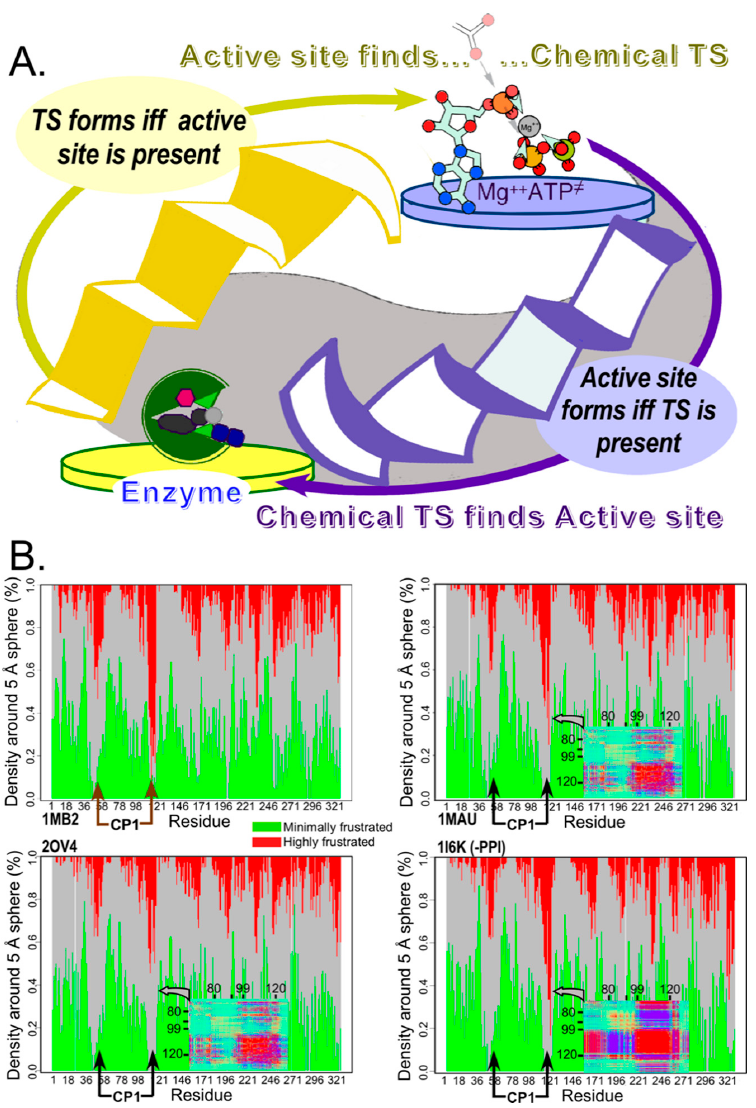
Figure 4. Reciprocally-coupled gating drove the evolution of catalysis. ( A ). The paradox of catalysis by molten globular ensembles is that both catalyst and reaction transition state are very rare species whose concentrations are too small to find one another often enough to accelerate the uncatalyzed rate. Yet the catalyzed rates of native and monomeric chorismate mutase are essentially the same, implying that the transition-state complex is as stable for the molten globular catalyst as for the native enzyme. The strange loop representing catalysis exhibits the same formal structure as those in Figures 1–3, in which both catalysis and folding are governed by bi-conditional if and only if statements for which the antecedent and consequent states are interchanged. ( B ). Structure-based bioinformatics evidence suggests that even native TrpRS retains features of such coupling. TrpRS crystal structures of ground-state (1MB2), activated Pre-transition state (1MAU), transition state analog (2OV4), and Products (1I6K) state complexes exhibit a progression in which the regions where the mobile CP1 domain is inserted into the Urzyme maximally relax their severe frustration [108,109] in the transition-state complex. The inserts in the last three frustratograms are vignettes of the covariance heat maps obtained from replica exchange Discrete Molecular Dynamics simulations, and show that correlate motion at the C -terminal boundary between the Urzyme and CP1 intensifies only in the Products state and only after release of product,